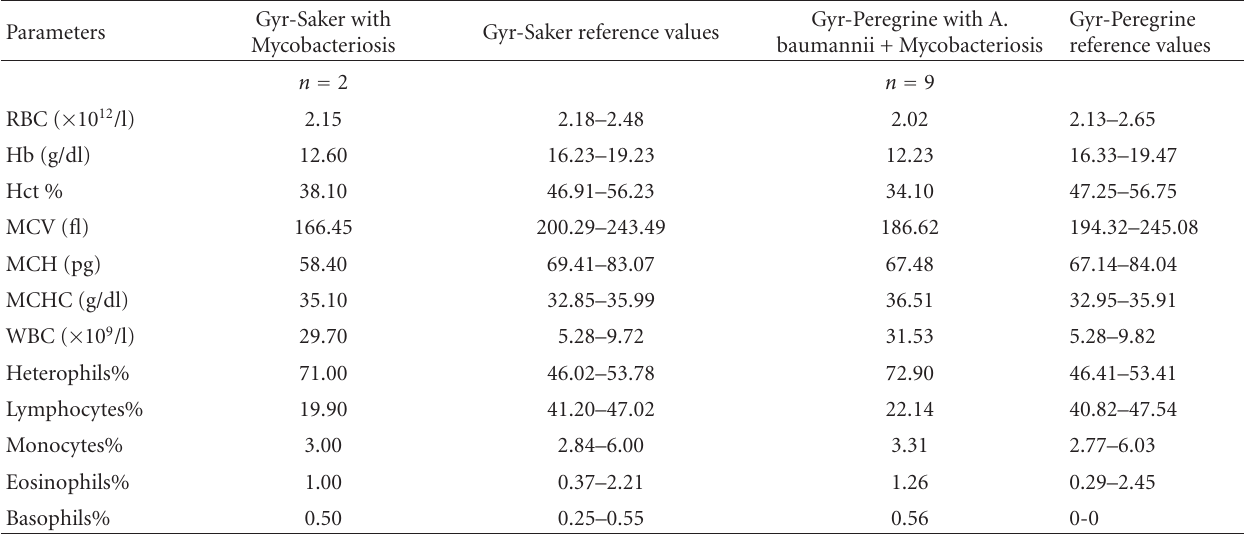
Table 2: Mean of hematology results of Gyr-Saker and Gyr-Peregrine hybrid falcons tested positive for A. baumannii and mycobacteriosis. Parameters